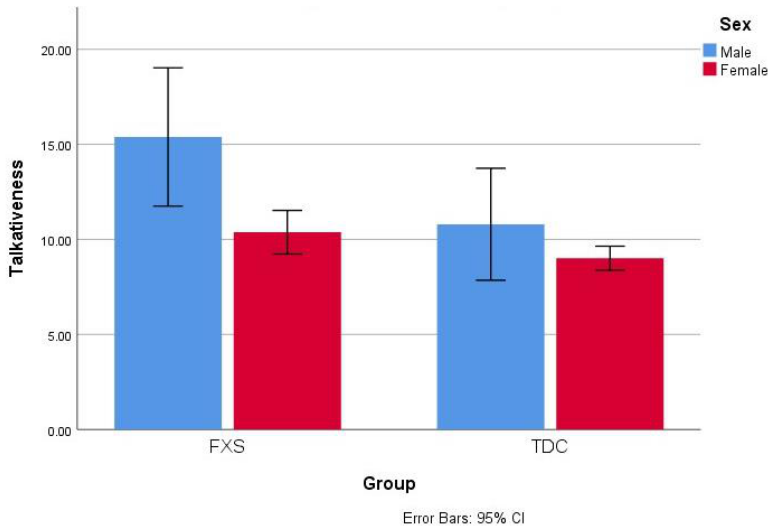
Figure 1. Talkativeness scores are demonstrated for fragile X syndrome (FXS) and typically developing control (TDC) groups and separated by sex. Error bars represent 95% confidence interval.